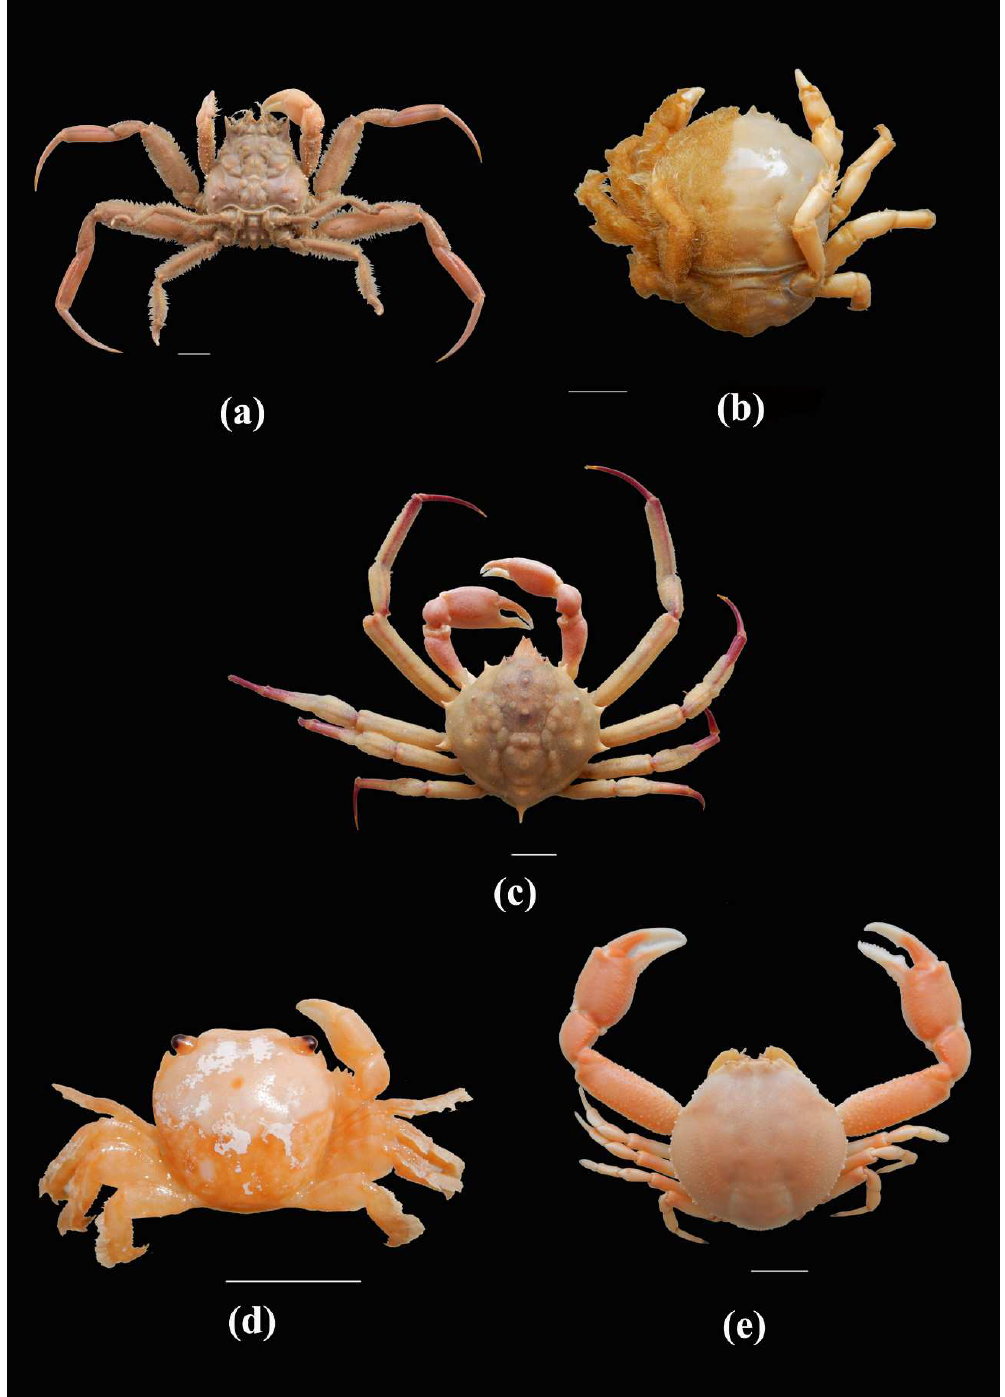
F IGURE 1. Entire animal dorsal view (a) Dorippe quadridens (Fabricius, 1793) male, CL: 31.4 mm; CW: 32.8 mm. (b) Lewindromia unidentata (Rüppell, 1830) Ovigerous female, CL: 27.6 mm, CW: 27.8 mm. (c) Doclea muricata (Fabricius, 1787) male, CL: 41.4 mm, CW: 37.5 mm. (d) Planes major (MacLeay, 1838) female CL: 13.00 mm, CW: 12.8 mm. (e) Lyphira perplexa Galil, 2009 male, CL: 29.9 mm, CW: 30.00 mm (Bar represent size = 1